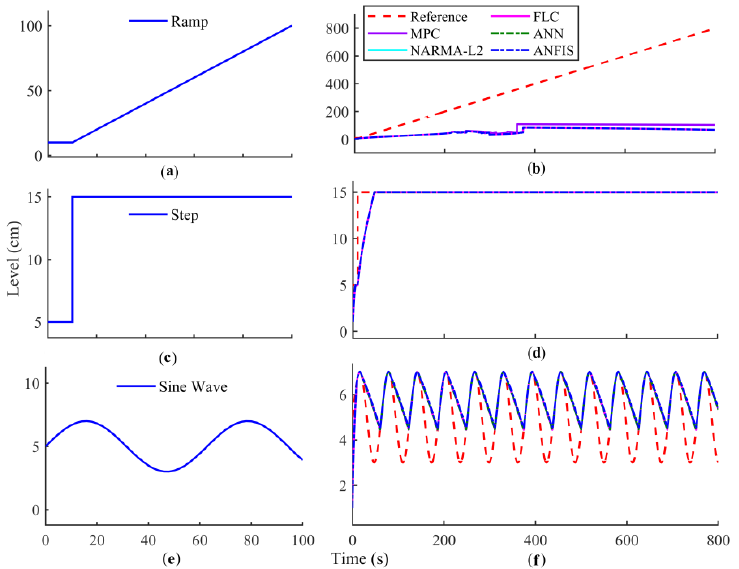
Figure 20. Response of closed-loop system to diverse input signals. ( a ) Ramp signal. ( b ) Response of the system to the ramp signal. ( c ) Step signal. ( d ) Response of the system to the step signal. ( e ) Sinusoidal signal. ( f ) Response of the system to the sinusoidal signal.